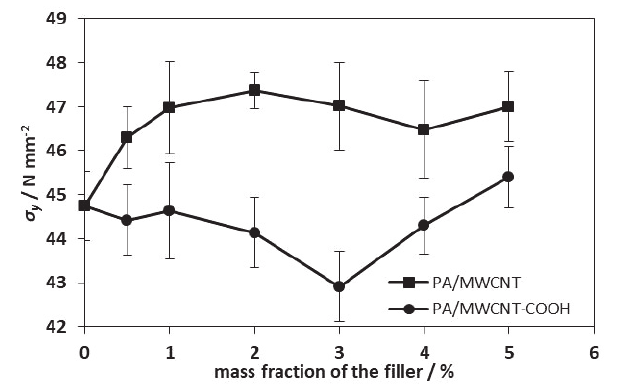
Fig. 12 – Influence of mass fraction of filler on yield stress of PA/MWCNT and PA/MWCNT-COOH nanocom- posites